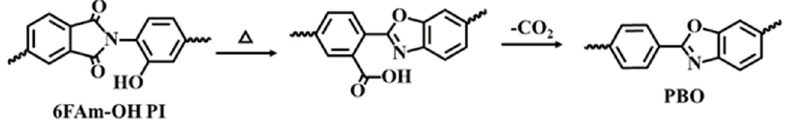
Figure 4. TGA thermograms of CPI membrane films with various PVA contents: ( a ) 6FAm PI and ( b ) 6FAm-OH PI.